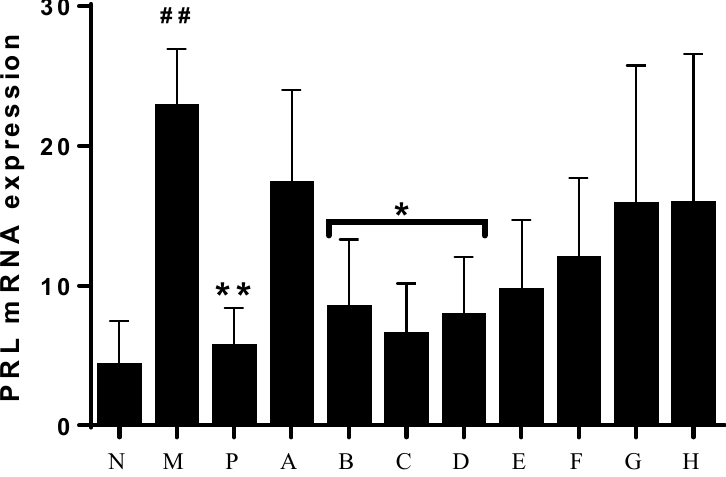
FIGURE 6 – The effects of decoction of different buds of malt on the expression of PRL mRNA in the pituitary gland of HPRL rat model. Rat model of HPRL was produced by back subcutaneous repeated injection with 75 mg/kg MCP, for 10 days, followed by treatment with or without 9.46 g/kg decoction of different buds of malt (A to H) or 0.4 mg/kg BMT (P) for 30 days. 0.9% salt solution treated rats were served as model group (M). Normal group were non-modeling and treated (N). At the completion of experimental treatment, tissues of pituitary gland of rats in each group were collected respectively. The expression of PRL mRNA was determined by PCR. Data are expressed as mean ± SEM (n = 6). ## P < 0.01 vs. normal group, * P < 0.05 and ** P < 0.01 vs. model